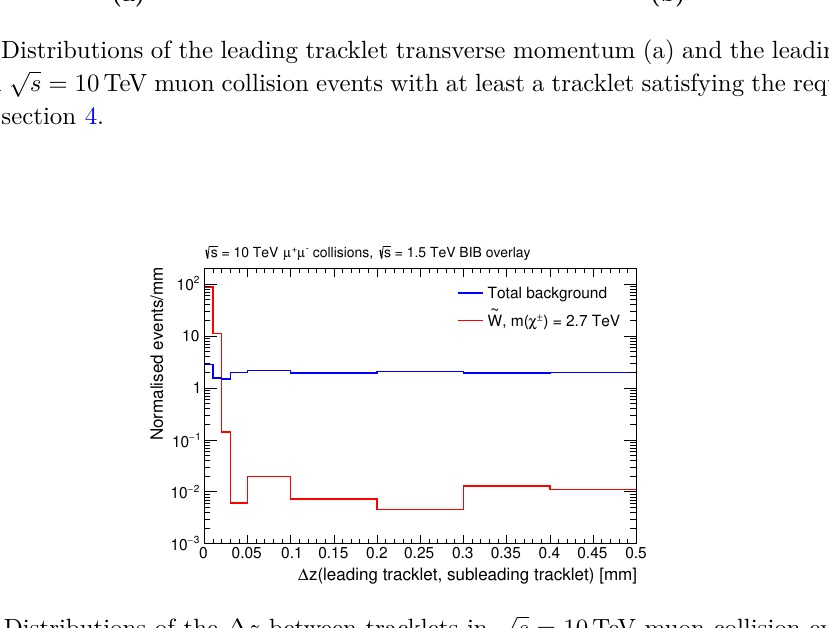
Figure 13. Distributions of the ∆ z between tracklets in at least two tracklets satisfying the requirements described in section